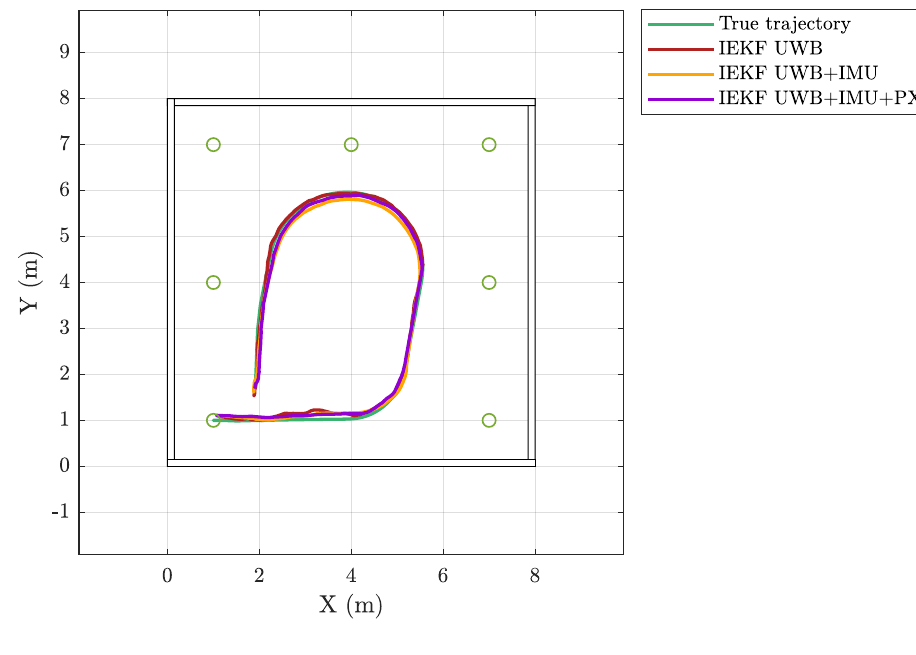
Figure 12. Trajectories using different sensors in scenario B.